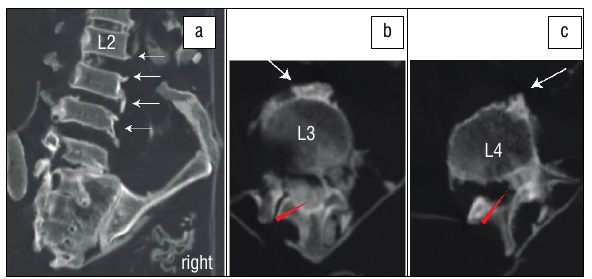
(a) Coronal slice of the lower vertebral column with degene- rative alterations (shown by arrows); and axial slices of (b) lumbar vertebra number 3 and (c) lumbar vertebra number 4 (red arrowheads show soil entering the spinal canal). The pelvic girdle was compressed. While the right hip joint was damaged, the left hip was intact with the head of the femur positioned inside the acetabulum. The joint space was filled with soil. The sacroiliac joints were intact, and some soil entered in the joint space on the left side. The chest was heavily compressed, mainly on the left side (Figure 6). The left shoulder girdle was moved dorsally whereas the right side was displaced more anteriorly. Both clavicles were rotated dorsally. While the costo-vertebral joints remained intact the ribs were luxated forward in many places and showed multiple fractures. These distortions and fractures are all the result of post-mortem/perimortem damage. The left thoracic cavity was filled with soil; the right thoracic cavity was empty. (a) Axial slice and (b) coronal slice of the skull of the Tuli mummy. No internal organs nor the mediastinum could be differentiated. Diverse large skin lesions (most likely post-mortem as a result of handling and taphonomic alterations) were found in the upper chest and neck area. While the left part of the abdomen was compressed, the right was mainly intact (Figure 6b). No internal organs could be identified. Again, the radiodense material (soil) was seen in the lesser pelvis.